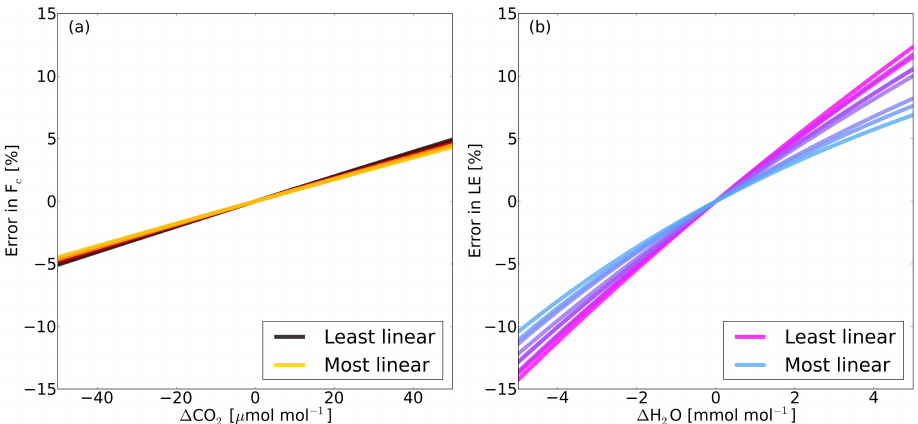
Fig. 4. Percentage errors ( y axis) in F c (a) and LE (b) resulting from various amounts of concentration biases ( x axis) applied on a typical mid- day half hour of raw eddy data, characterized by F c ≈ − 23µmolm − 2 s − 1 ; LE ≈ 210Wm − 2 and average concentrations of 375µmolmol − 1 (CO 2 ) and 13mmolmol − 1 (H 2